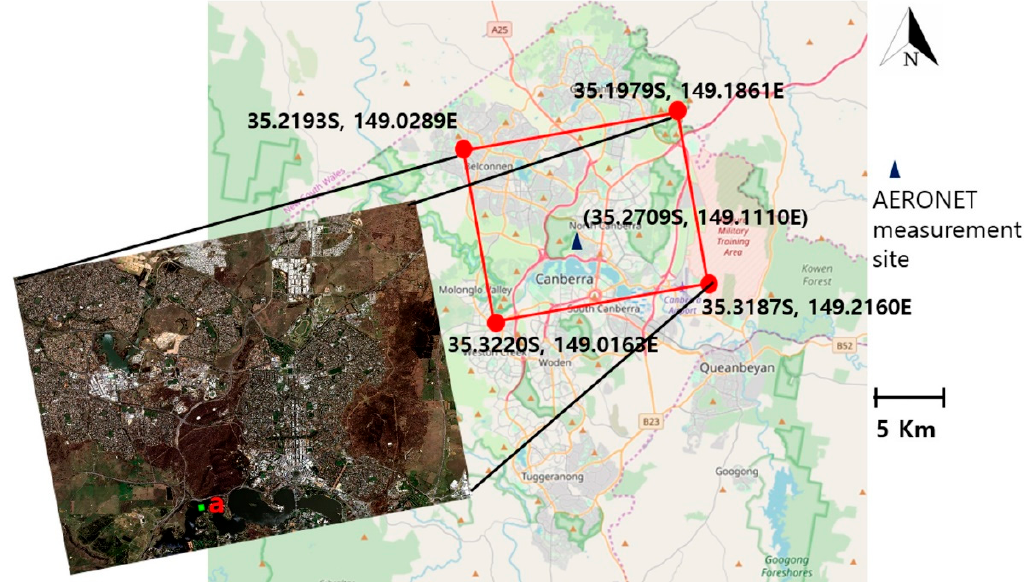
Figure 5. Canberra region, Australia, covered by KOMPSAT-3A (7 February 2016) and a measurement station point for the AERONET data.